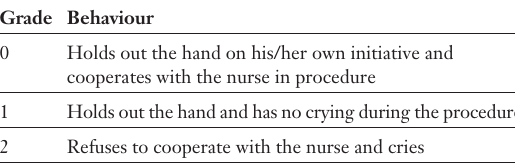
Cooperative behav- iour scale of children in venepuncture